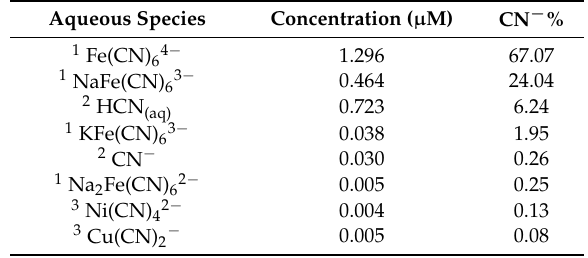
Table 3. Aqueous cyanide species for well #1 (E33-268), based on speciation modelling of well groundwater chemistry contemporaneous to the date of groundwater collection for this study. Strong-acid dissociable (SAD), weak-acid dissociable (WAD), and free cyanide account for 93.29, 0.21, and 6.49% of species, respectively.